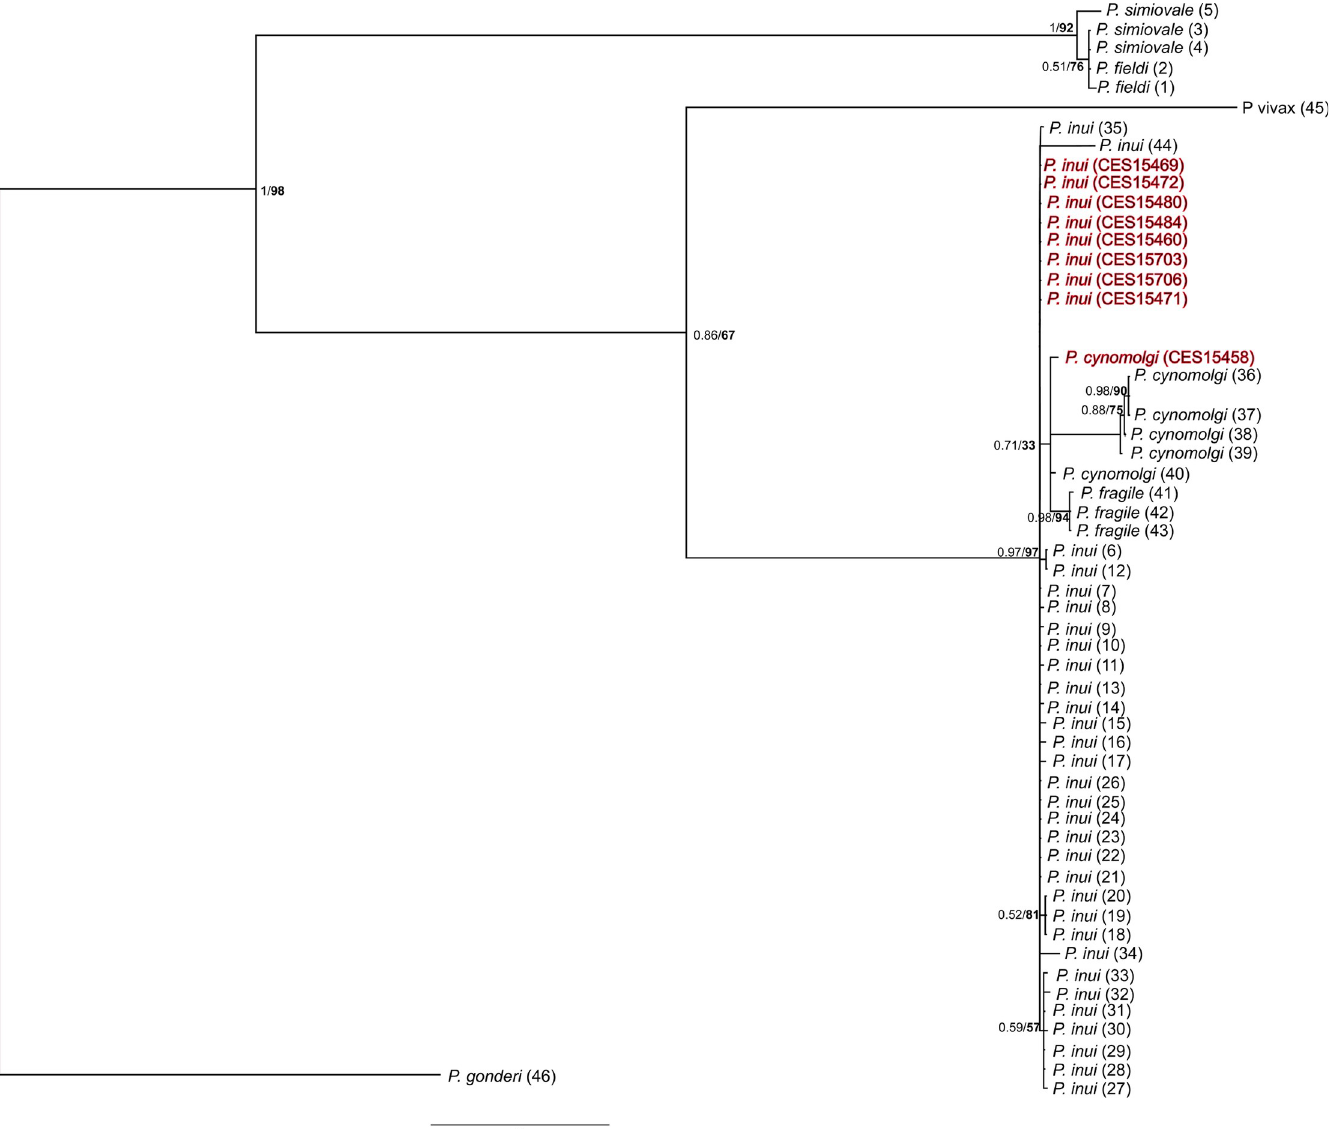
Fig 4. Phylogenetic tree of Plasmodium species based on nuclear genome 18s rRNA gene. Bayesian and ML methods yielded similar tree topologies and so only Bayesian tree is shown. The values above branches are posterior probabilities together with the bootstrap values (in bold) in percentage obtained for ML tree.